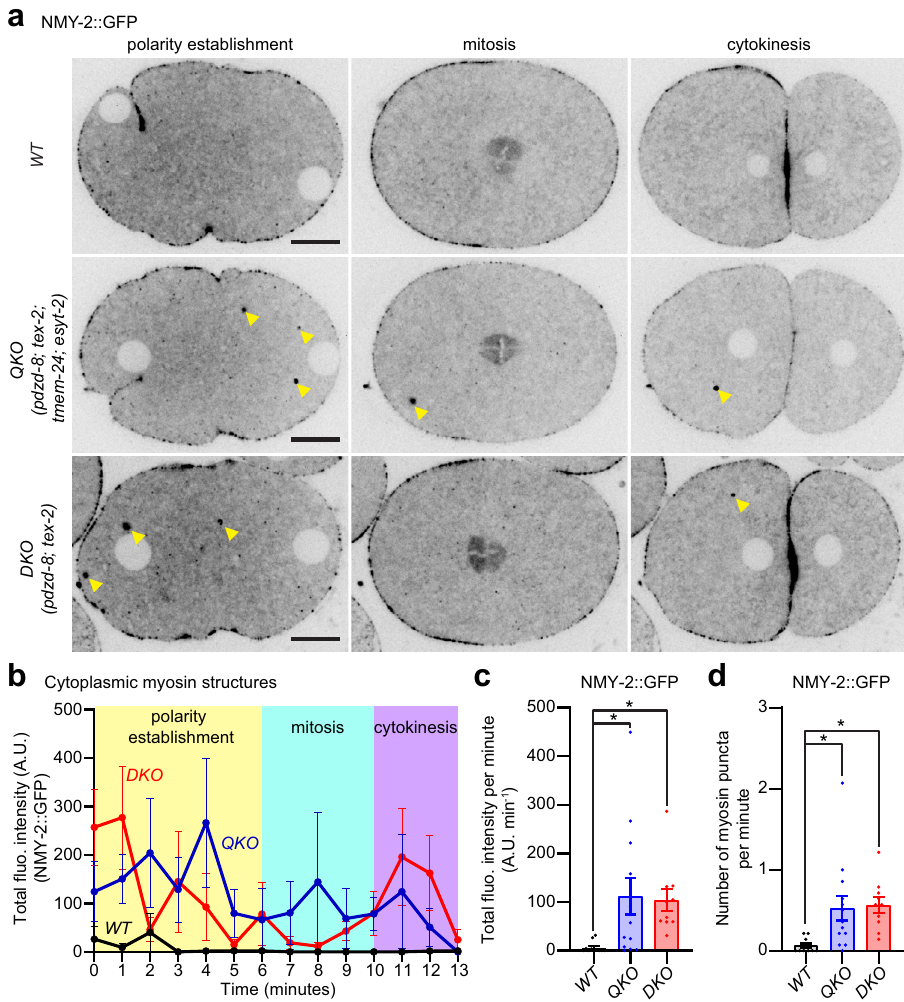
Fig. 3 Redundant functions of PDZD-8 and TEX-2. a Representative live spinning disc confocal (SDC) images of equatorial planes of early embryos from wild-type control (WT), mutant lacking all the four SMP proteins [quadruple knock-out: QKO (pdzd-8; tex-2; tmem-24; esyt-2) ] and mutant lacking PDZD-8 and TEX-2 [double knock-out: DKO (pdzd-8; tex-2) ], expressing NMY-2-tagged with GFP (NMY-2::GFP). Images of each row are from time-lapse movies of the same embryos at different phases as indicated. Note the presence of ectopic NMY-2::GFP puncta, indicated by yellow arrowheads, in QKO and DKO embryos compared to a WT embryo. Scale bars, 10 μ m. b Time-course analysis of the total fl uorescence intensity of NMY-2::GFP puncta during polarity establishment (0 – 6 min), mitosis (6 – 10 min), and cytokinesis (10 – 13 min) phases for WT, QKO, and DKO early embryos as shown in ( a ) [mean ± SEM, n = 11 embryos (WT), n = 13 embryos (QKO), n = 10 embryos (DKO)]. c Quanti fi cation of the total fl uorescence intensity of NMY-2::GFP puncta per minute during early embryogenesis (0 – 13 min). Comparisons between WT, QKO, and DKO early embryos are shown [mean ± SEM, n = 11 embryos (WT), n = 13 embryos (QKO), n = 10 embryos (DKO); Dunnett ’ s multiple comparisons test, * p = 0.0171 (QKO), * p = 0.0417 (DKO)]. d Quanti fi cation of the number of NMY-2::GFP puncta per minute during early embryogenesis (0 – 13 min). Comparisons between WT, QKO, and DKO early embryos are shown [mean ± SEM, n = 11 embryos (WT), n = 13 embryos (QKO), n = 10 embryos (DKO); Dunnett ’ s multiple comparisons test, * p = 0.0123 (QKO), * p = 0.0113